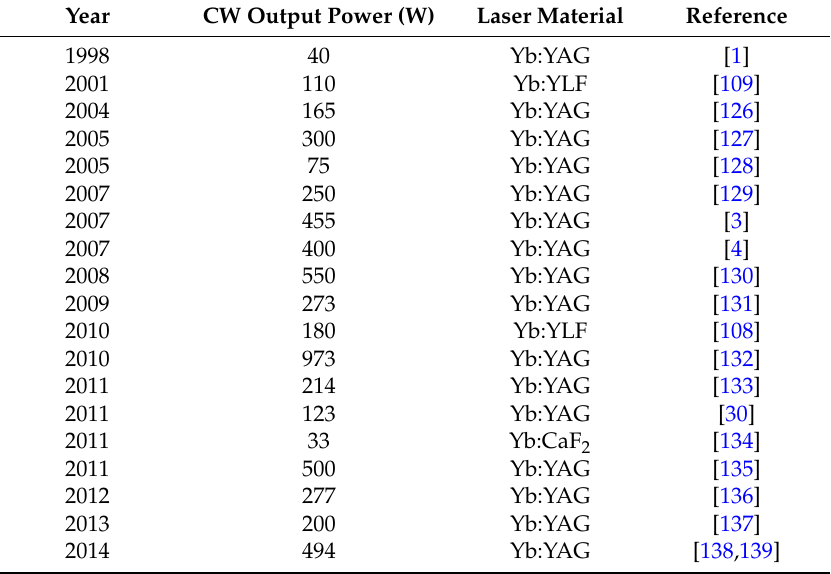
Figure 44. CW output power at 1029 nm from demonstrated Yb:YAG and Yb:YLF cryogenic lasers in the years 1998–2015. Table 7. Reported Cryogenic CW Yb:YAG and Yb:YLF Demonstrations From 1998–2015.